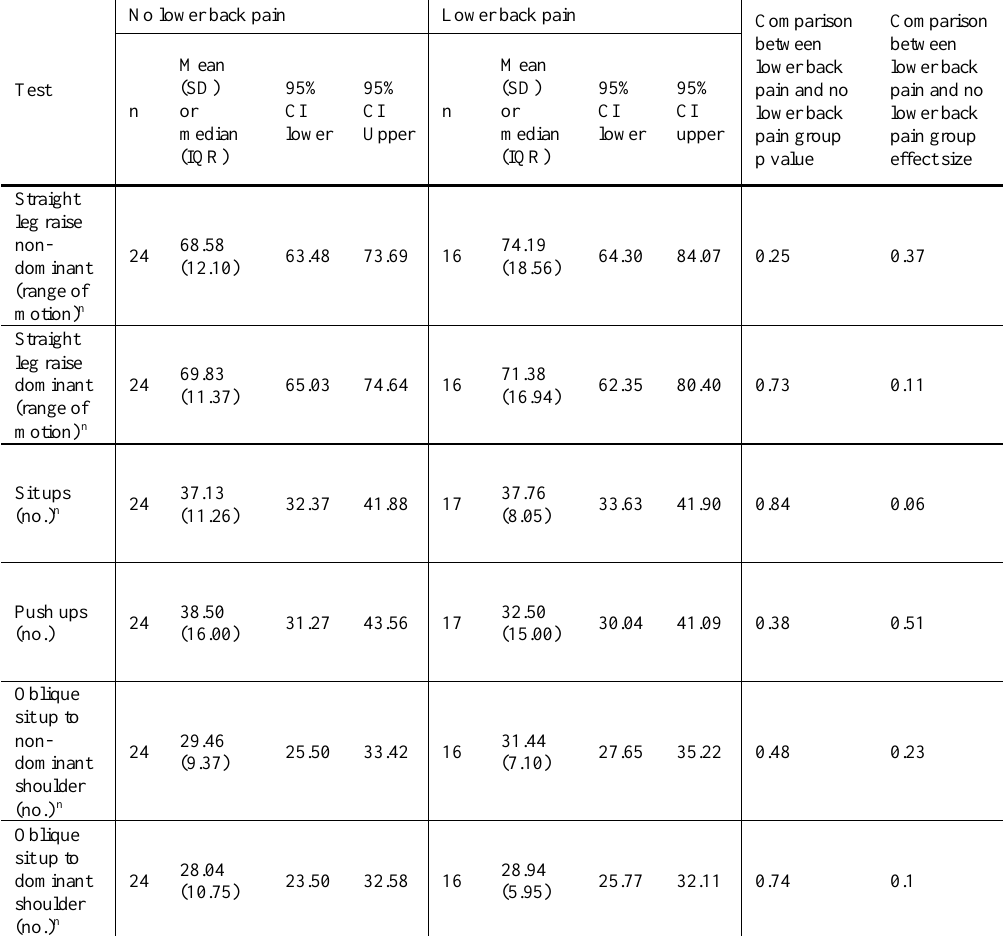
Table comparing continuous screening test results for those with lower back pain compared to those without lower back pain